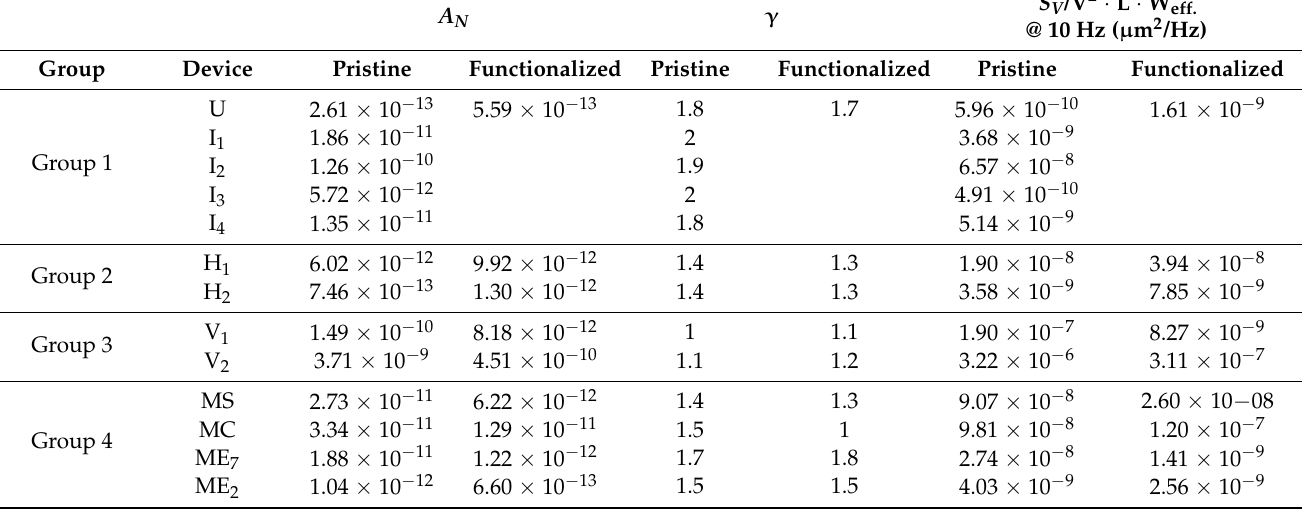
Table 6. The 1/ f current noise spectra parameters (Hooge and gamma) for pristine and functional- ized graphene (open slots indicate devices missing (printing flaws) due to processing issues) and channel-area normalized noise from an extrapolation to 10 Hz. For comparison, previous work of Rumyatsev et al. [4] reported a channel-area normalized noise range between 1 × 10 − 8 and 1 × 10 − 7 µ m 2 /Hz. S V /V 2 · L · W eff. A N γ @ 10 Hz ( µ m 2